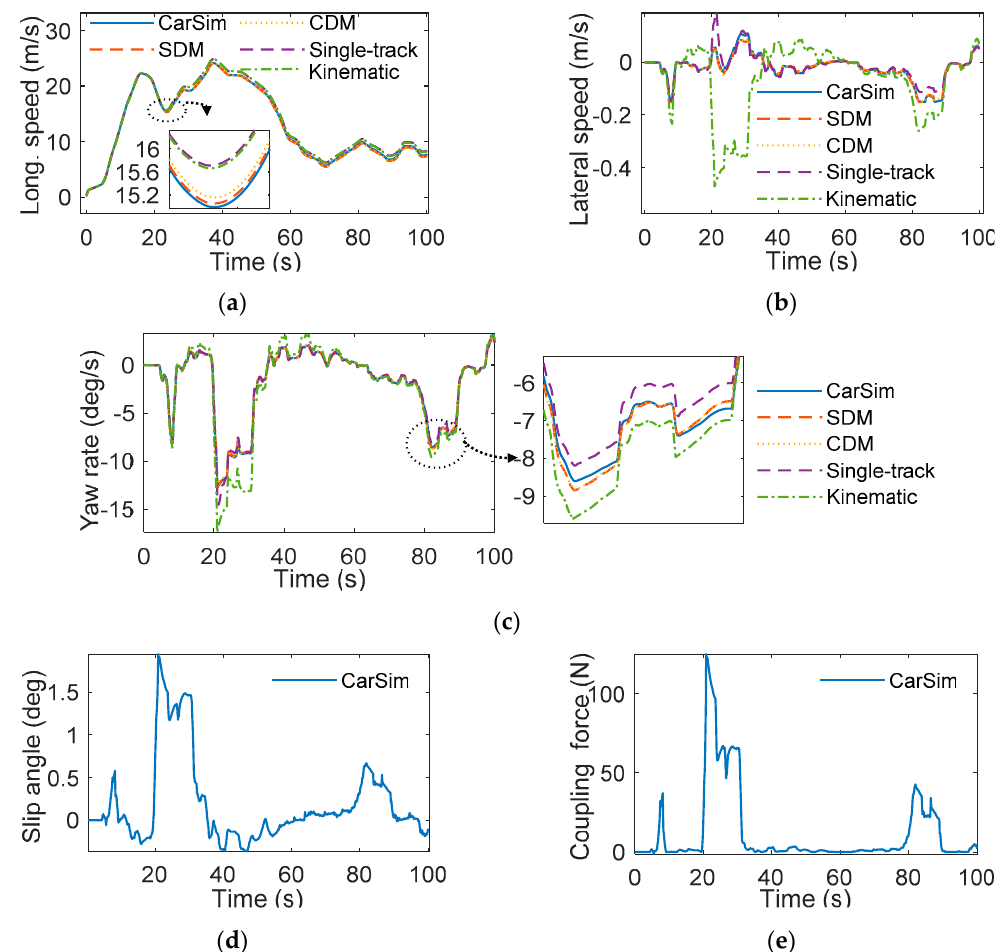
Figure 6. Comparative results. ( a ) Longitudinal speed. ( b ) Lateral speed. ( c ) Yaw rate. ( d ) Slip angle of front tire. ( e ) Lateral coupling force in longitudinal direction.